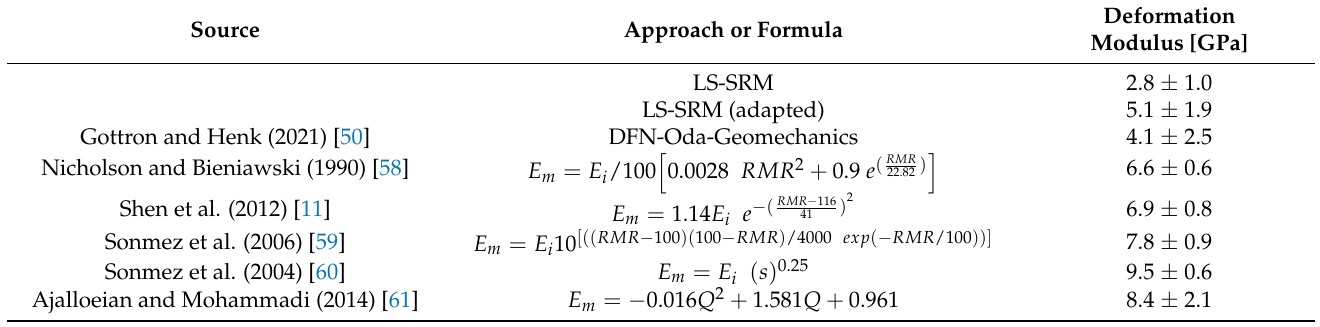
Table 9. Comparison of the rock mass deformation modulus using the LS-SRM approach, DFN-Oda-Geomechanics approach and empirical equations based on empirical rock mass classification schemes.